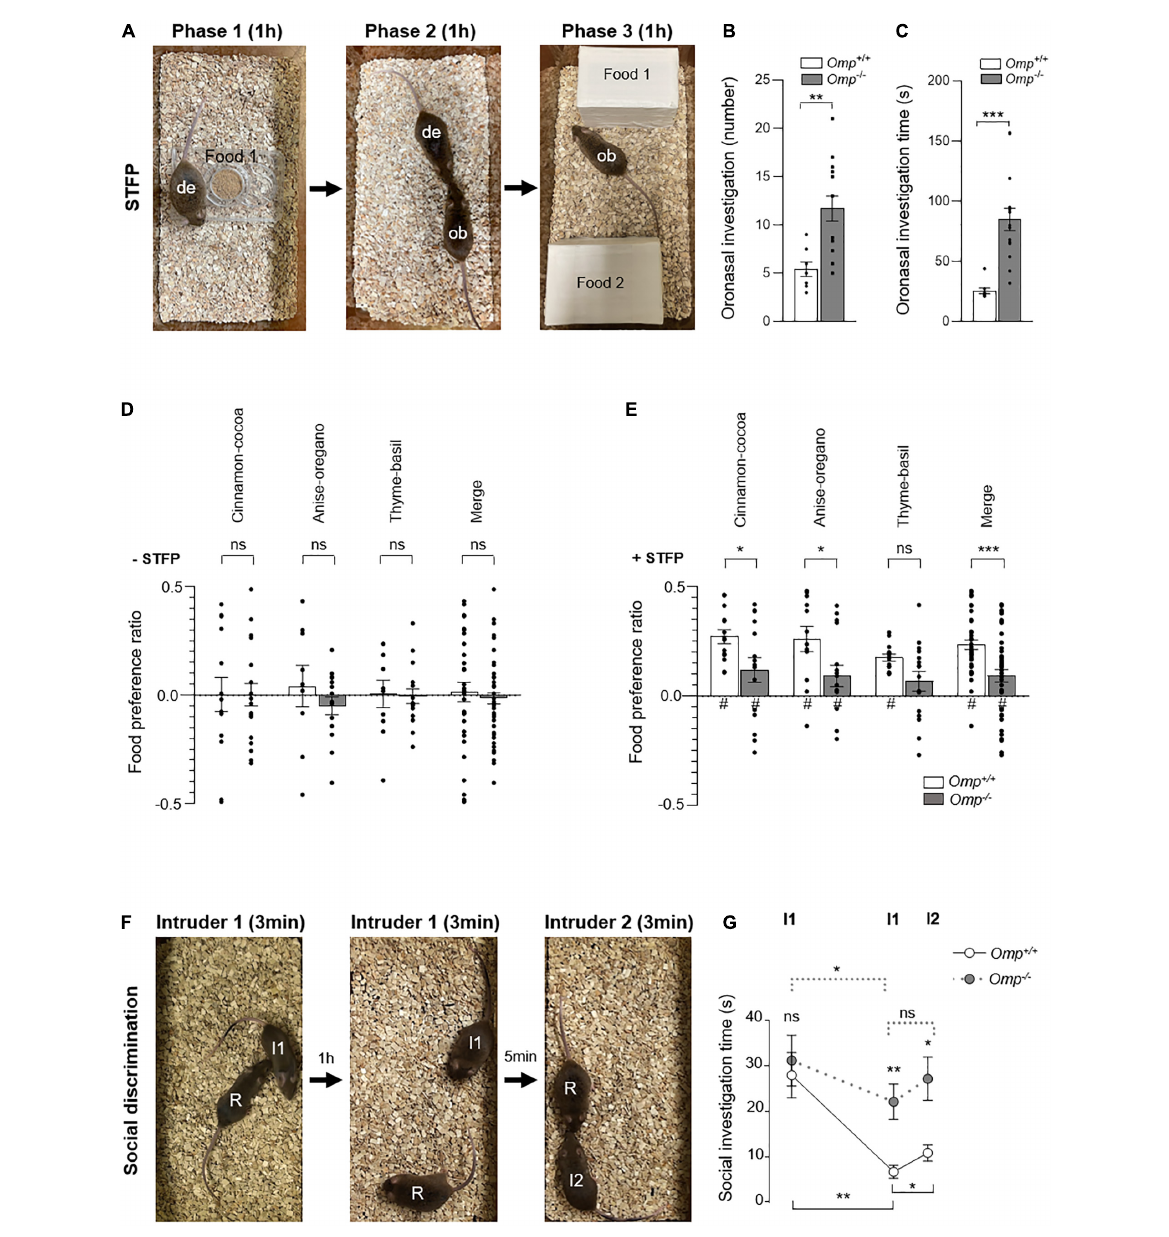
FIGURE4 Altered social transmission of food preference and discrimination in OMP null mice. (A–E) Social transmission of food preference (STFP) assay. (A) The demonstrator mouse (de) eats the demonstrating food (Food 1; Phase 1) during 1 h before it returns with its littermates. Then, oronasal interactions between the demonstrator (de) mouse and an observer (ob) mouse to transmit olfactory information about the novel food (Phase 2) are performed during 1 h. Then, the ob mouse is faced with the two choice assay (Food 1 vs. Food 2; Phase 3) during 1 h. The Omp − / − mice (in gray) show a significant increase in the number (B) and the duration (C) of oronasal investigations compared to Omp + / + . (D) In absence of STFP procedure (–STFP), both mice genotypes show no innate preference for the three couples of spices used: Cinnamon-Cocoa, Anise-Oregano and Thyme-Basil when presented in a counterbalanced mode. (E) After STFP (+ STFP), Omp − / − mice showed a significantly altered acquisition of food preferences for each of the three tested couples of spices as well as in the merged data (Merge). (F,G) Social discrimination test. (F) The social investigation performed by a Resident (R) mouse is observed when a never encountered before Intruder 1 (I1) is introduced into the cage during 3 min. After 1 h, Intruder 1 is reintroduced into the cage and the social investigation time performed by the Resident mouse is again quantified during 3 min. After 5 min, another Intruder mouse (I2) is then presented and the 3 min of social exploration time performed by the Resident mouse are quantified. (G) Statistical analysis of the social investigation time performed in panel (F) for Omp + / + (white circles and continuous line) and Omp − / − mice (gray circles and dashed line) mice. N = 6–16 (B–E) and 6–7 (G) animals were used per condition and genotype. Values obtained are represented as mean ± SEM. For food preference z values, # p < 0.05. For comparisons between genotypes, two-tailed Student’s t -tests/Wilcoxon w -tests were used; for comparisons between conditions (G) , one-tailed paired Student’s t -tests were used, * p < 0.05, ** p < 0.01, *** p < 0.001 and ns for